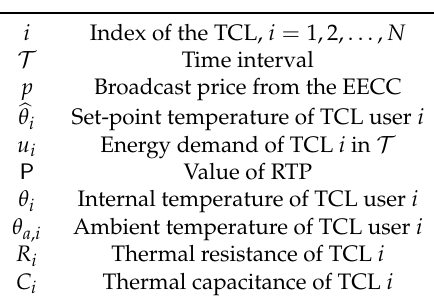
Table 1. Variables and